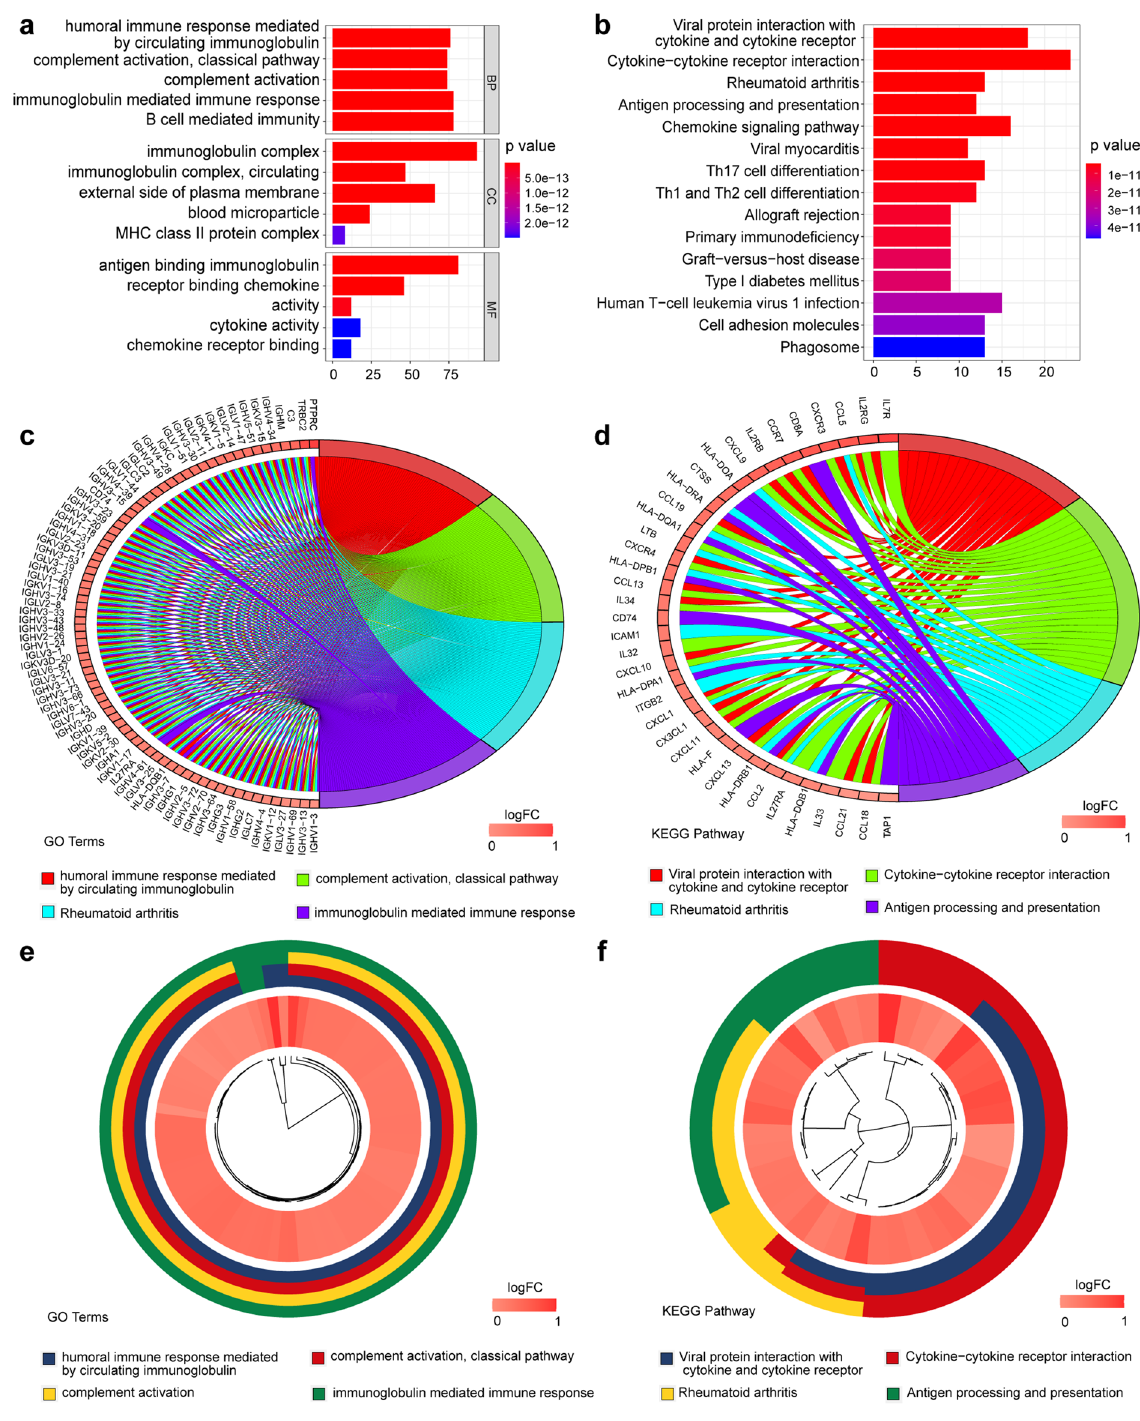
Figure 4. Enrichment analysis of WAKMAR2-related immune